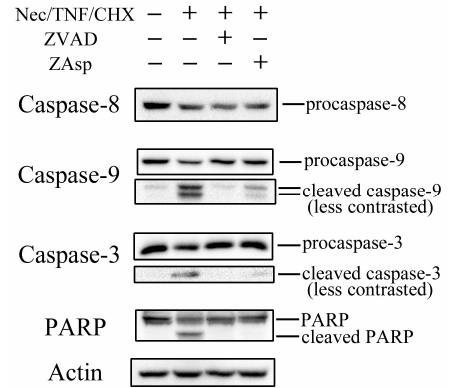
Figure 6. Western blot analysis of proteolytic activation of Caspases. L929 cells were treated with 10 μ M necrostatin-1 (Nec), 10 ng/mL TNF, and 10 μ g/mL cycloheximide (CHX) with or without 10 μ M Z-VAD-fmk (ZVAD) or 100 μ M Z-Asp-CH 2 -DCB (ZAsp) for 5 h, and Western blot analysis of